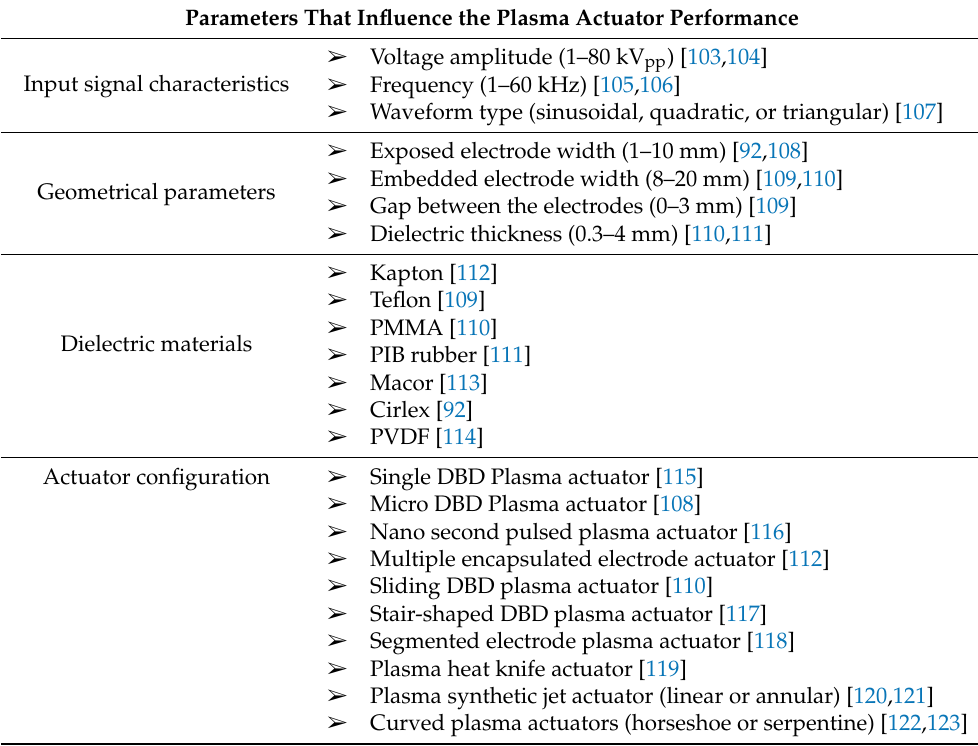
Table 2. Summary of the main parameters that influence the DBD plasma actuators